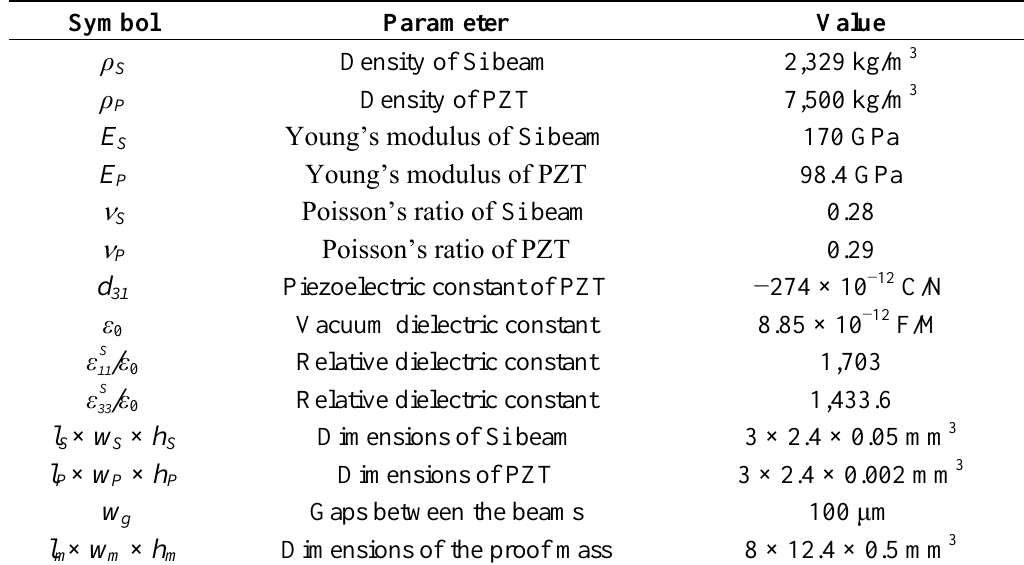
Table 1. Material properties and structural parameters of the piezoelectric energy